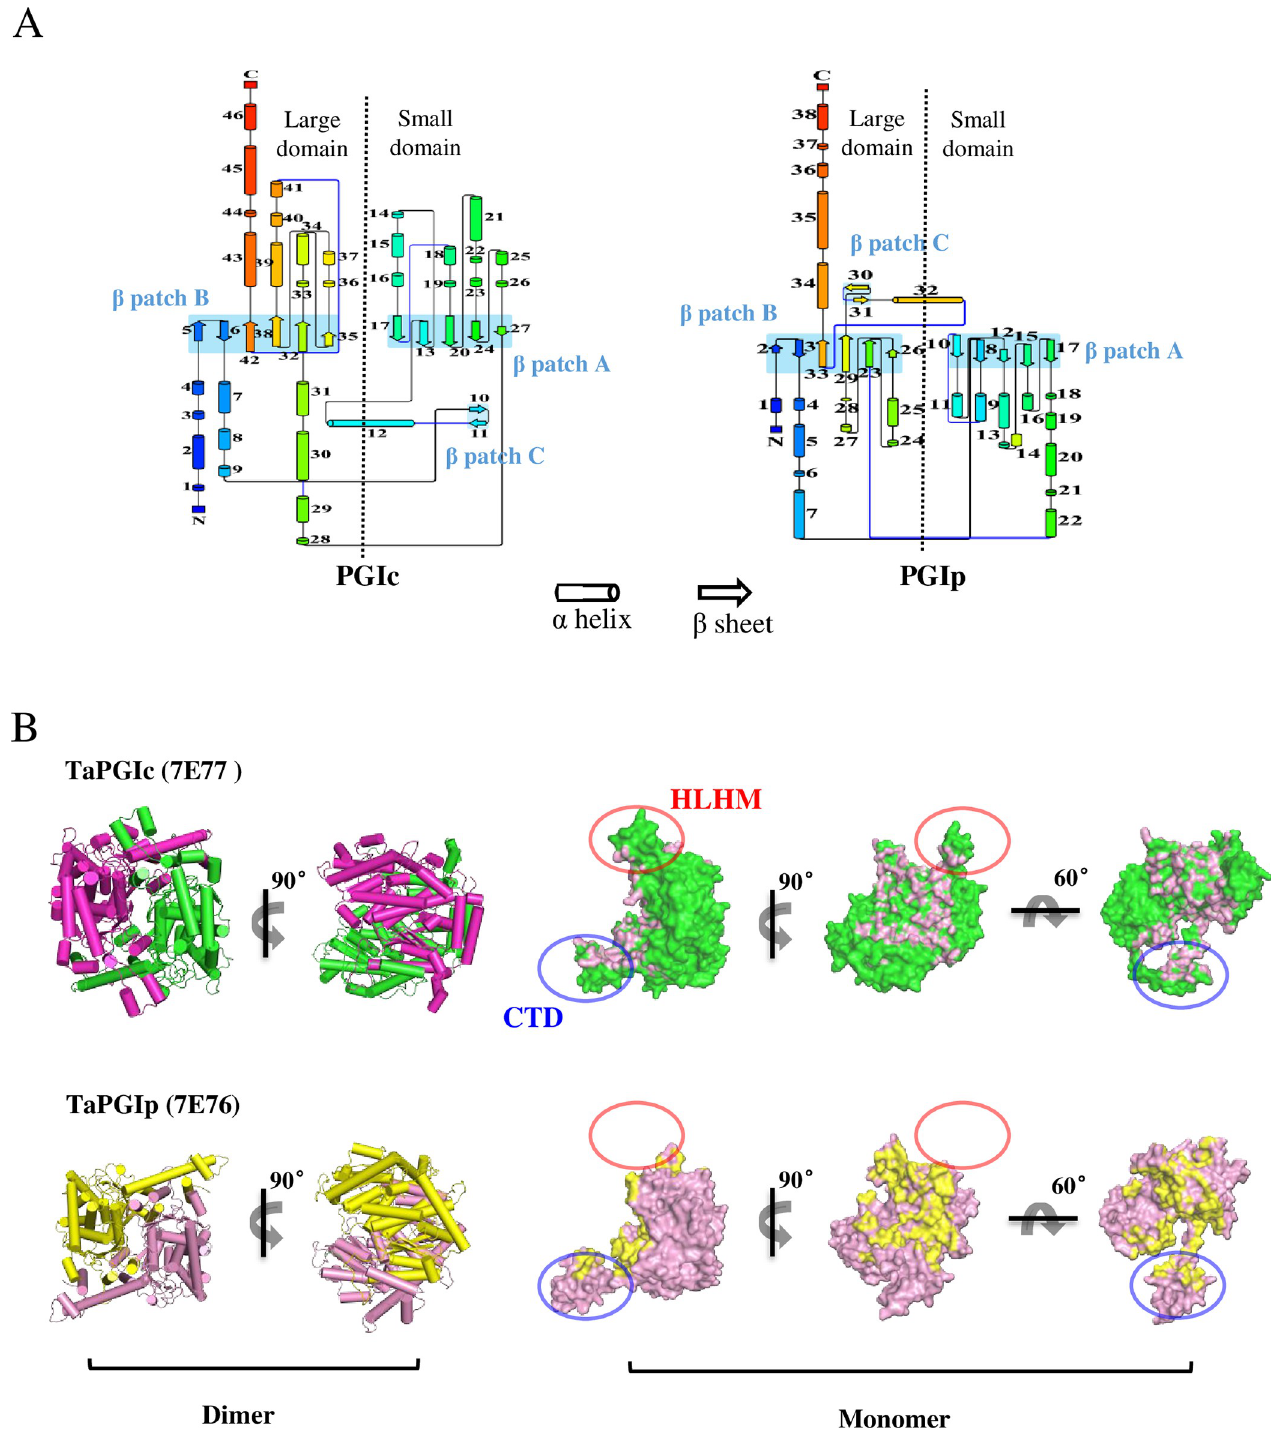
Fig 1. The crystal structures of TaPGIc and TaPGIp. A. Second structure topology map of TaPGIc and TaPGIp in their crystal structures. TaPGIc has 46 basic secondary structure elements, and TaPGIp has 38 similar elements. Both TaPGIs contain three groups of β -strands, termed β patches (A, B, and C), and each β patch is composed of various numbers of β -strands. The cylinder indicates the α helix, and the broad arrow indicates the β -strand. B. Overall structures of the TaPGIc and TaPGIp complexes (dimer conformation and monomer conformation). The architecture of TaPGIc is shown in magenta and green, and TaPGIp is shown in yellow and pink. The dotted circles show two different regions between TaPGIc and TaPGIp, named “HLHM” (highlighted by red circle) and “CTD” (highlighted by blue circle). PGIc HLHM is from 444aa to 466aa. PGIc CTD is from 510aa to 567aa, and PGIp CTD is from 467aa to 557aa.